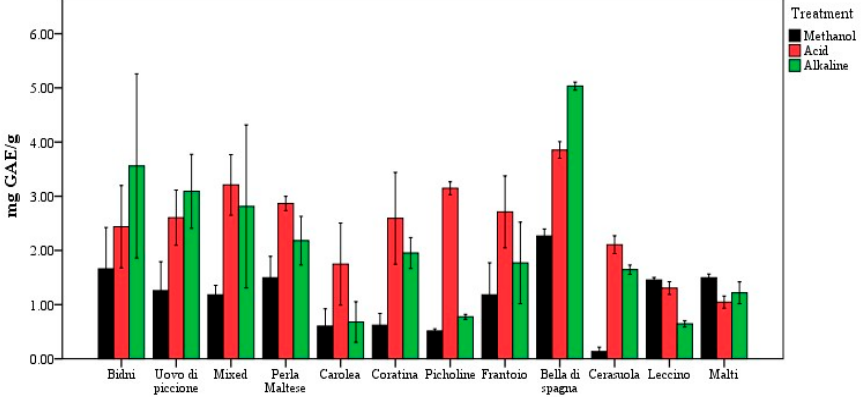
Figure 2. Mean values for total phenolic content (TPC) of olive mill waste extracts using three different solvent extraction methods—methanol, acid and alkaline (black, red and green bars, respectively) with error bars showing ± 1SD for three independent trails.